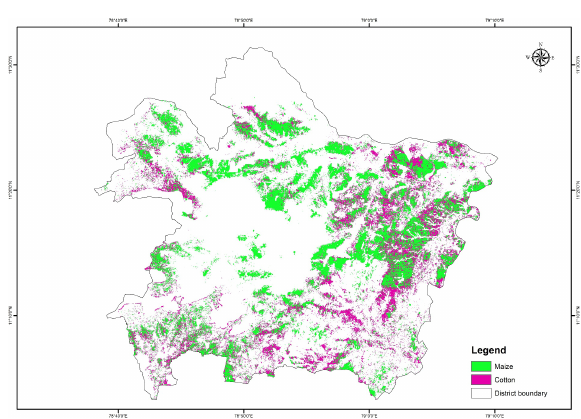
Figure 8. Classified image using unsupervised classification for Landsat 8